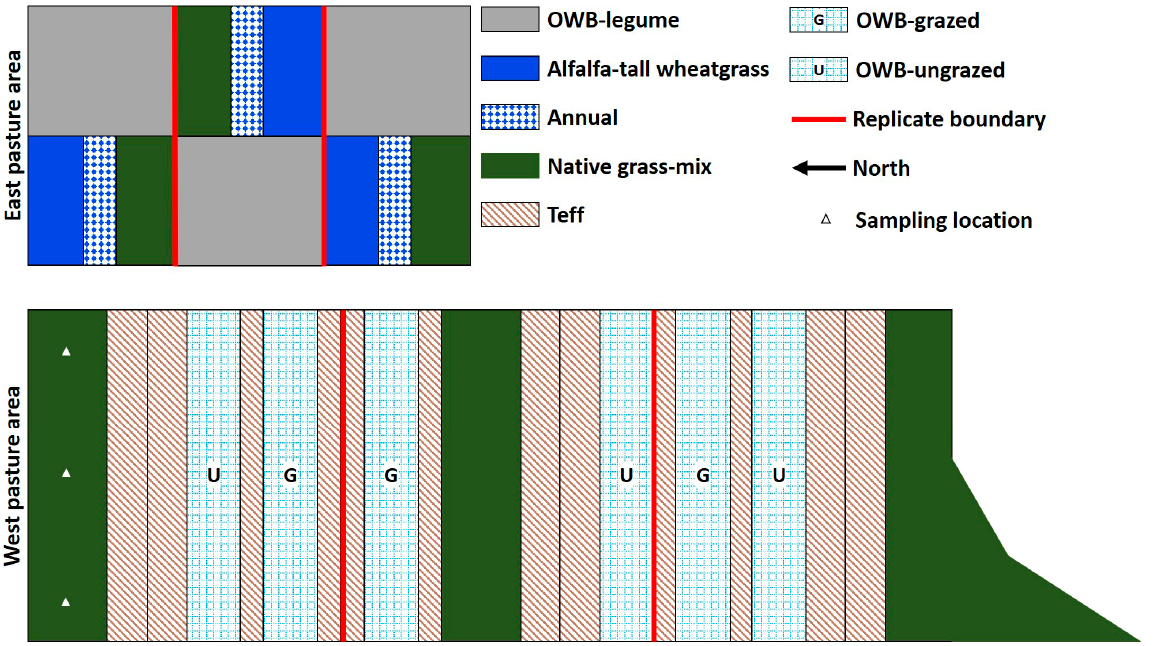
Figure 2. Forage crops grown in the experimental treatment plots during the 2016–2017 growing season at New Deal, Texas, USA (not drawn to scale). The cultivar of Old-World bluestem (OWB) was WW-B. Dahl. Triangles in the west native grass-mix pasture represent soil sampling locations as an example for all other pastures.